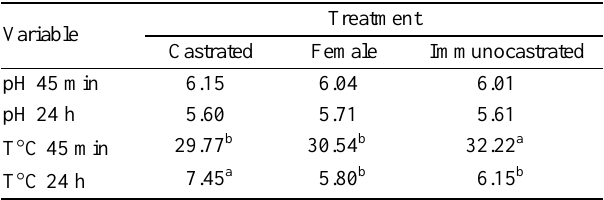
Means followed by different letters in the line differ between them by Tukey test